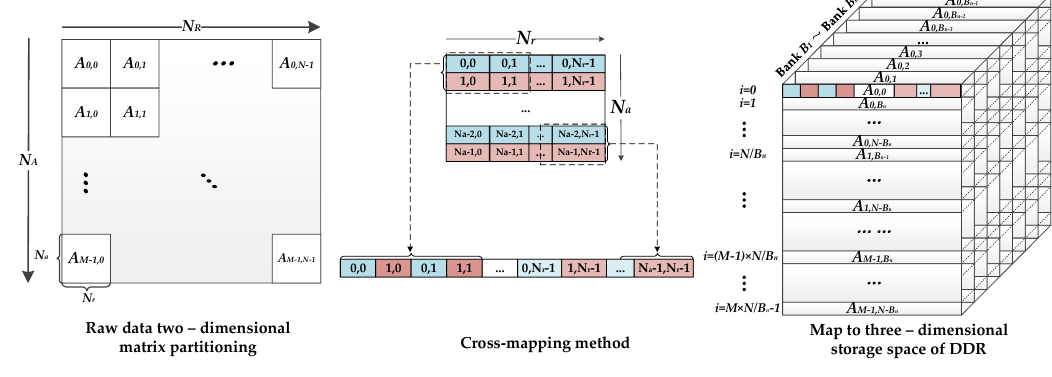
Figure 7. Cross-mapping method.